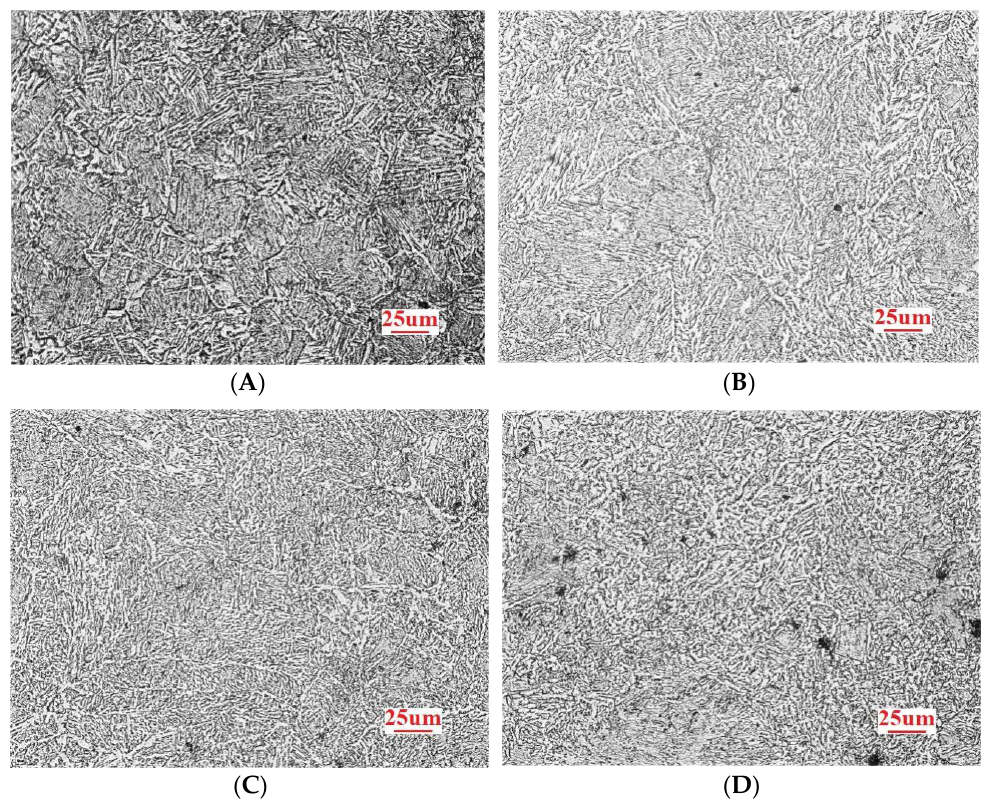
Figure 10. The microstructure of the fracture surface of the tensile specimen of the samples ( A – D ) at 850 °C.